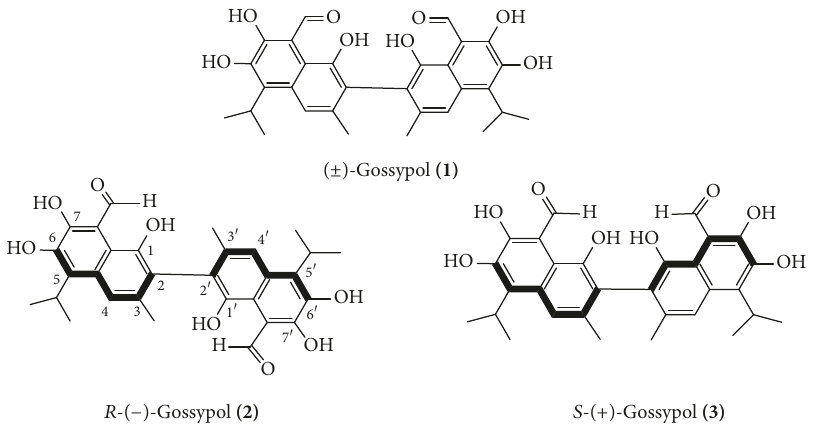
Figure 1: Racemic gossypol and its